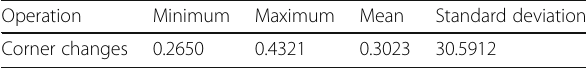
Table 8 Results of corner forgery for 50 forged image set Operation Minimum Maximum